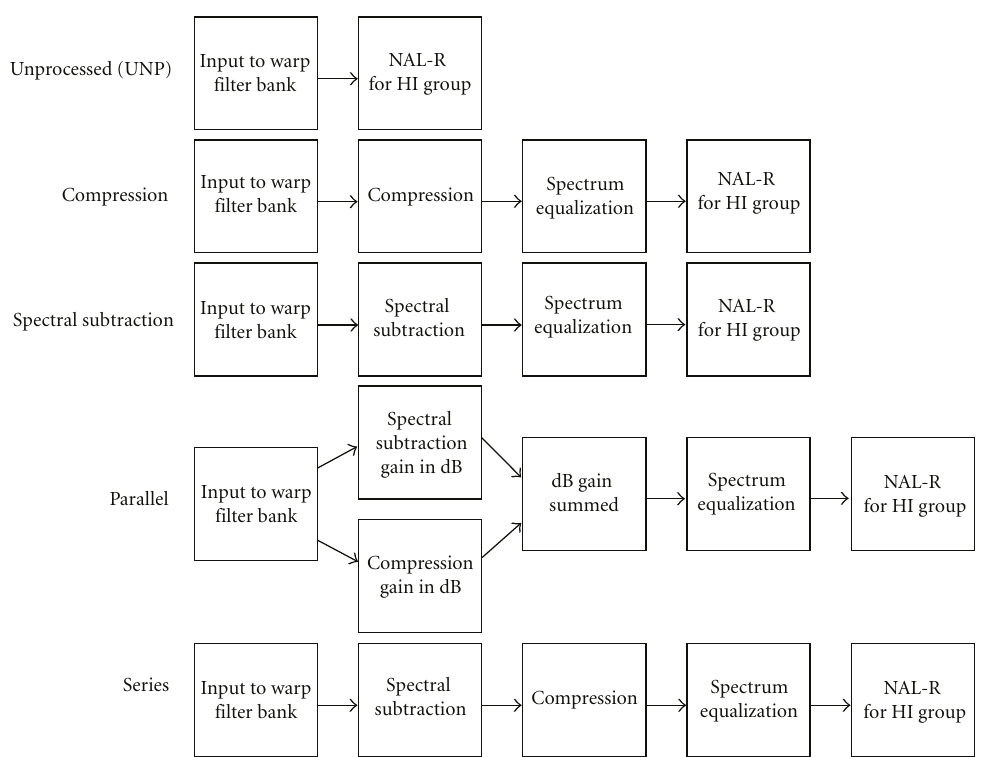
Figure 2: Block diagrams depicting the five processing conditions showing each stage of processing.